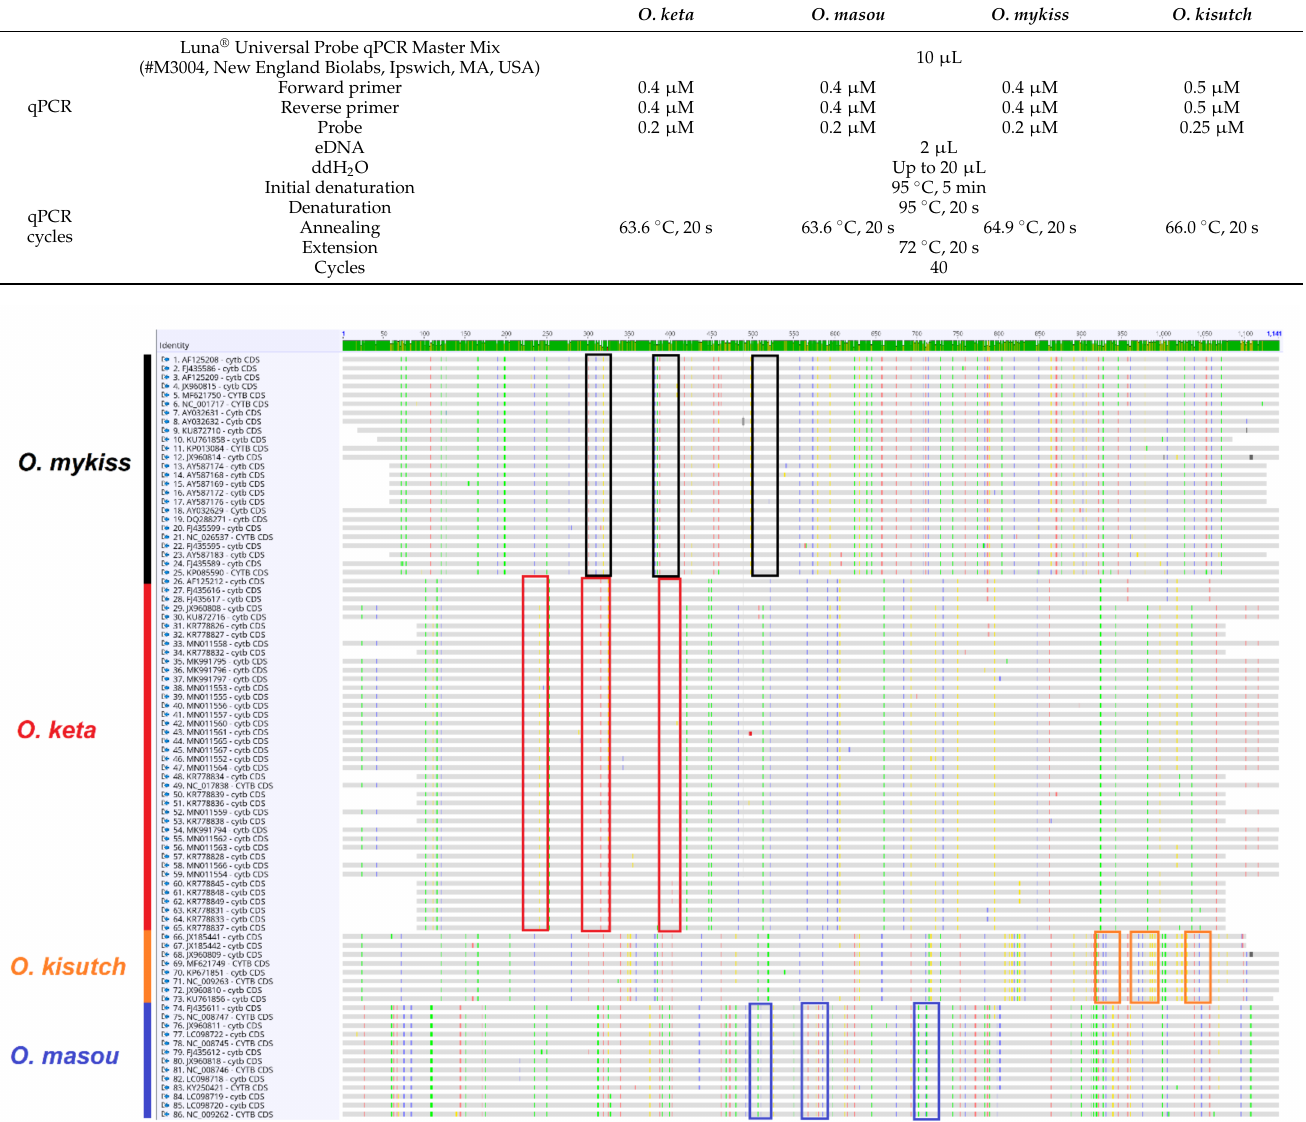
Table A2. Quantitative PCR conditions for each salmon species.